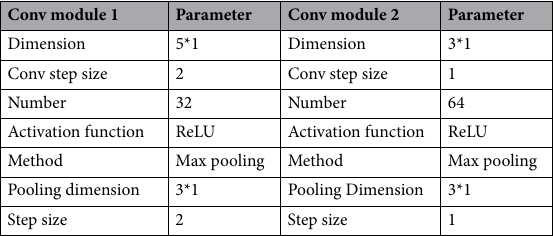
Table 1. Convolution module parameter